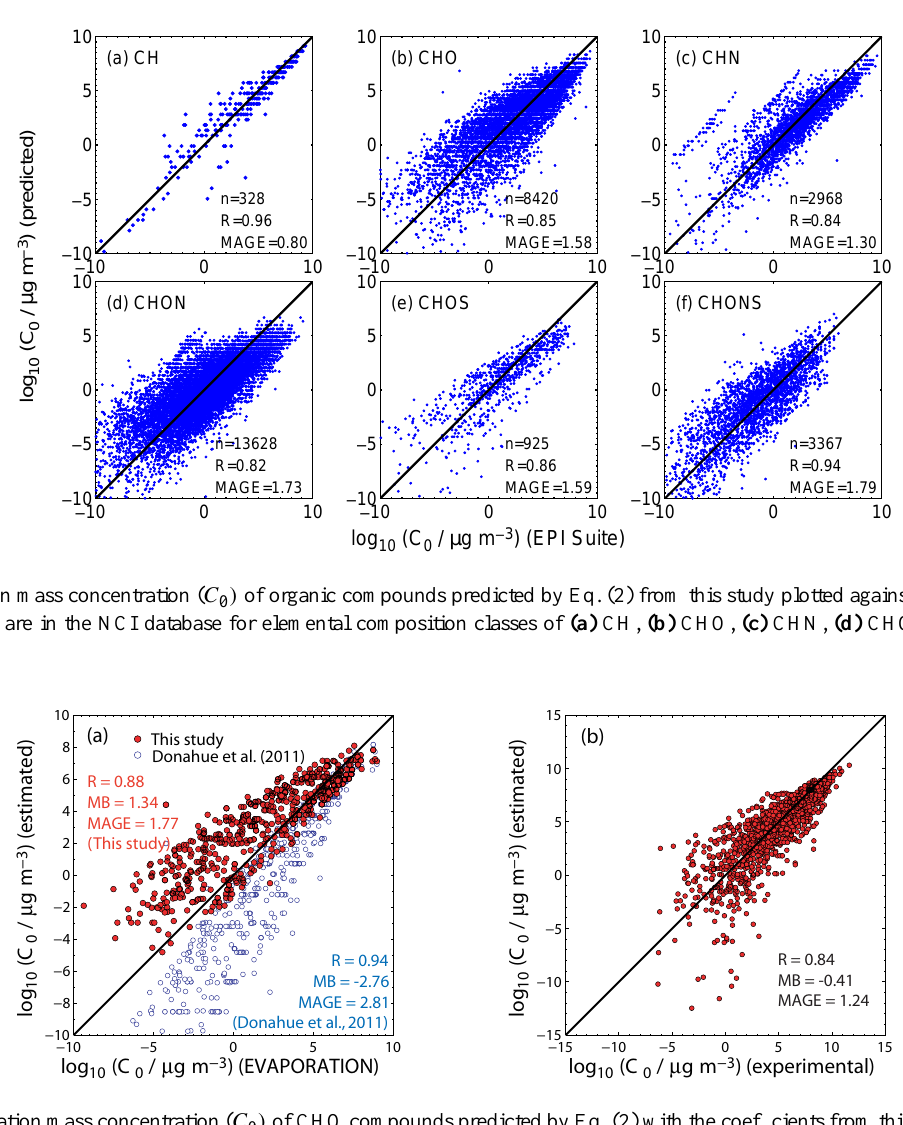
Figure 4. (a) Saturation mass concentration ( C 0 ) of CHO compounds predicted by Eq. (2) with the coefficients from this study and with the coefficients from Donahue et al. (2011) plotted against C 0 computed by the EVAPORATION model (Compernolle et al., 2011). The data comprise 704 SOA oxidation products from biogenic (isoprene, α -pinene, limonene, glyoxal) and anthropogenic precursors (C12 alkanes) as presented in Shiraiwa et al. (2014). (b) Comparison of C 0 predicted by Eq. (2) in this study and experimental values taken from PHYSPROP Database